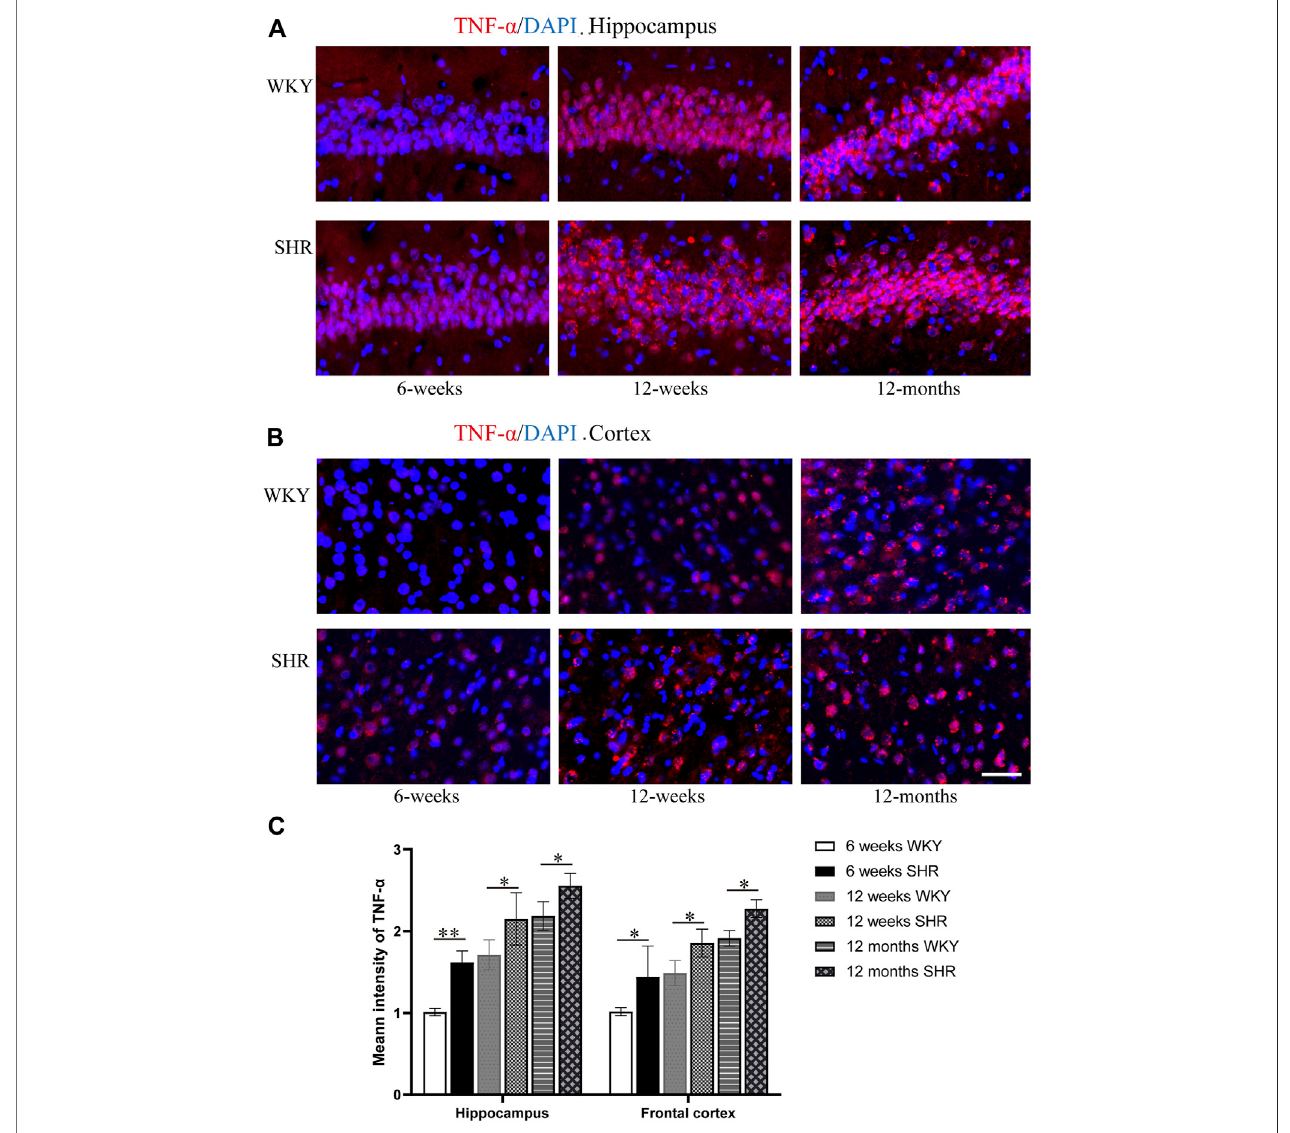
FIGURE7| TNF- α immuno fl uorescenceshowedthattheexpressionofTNF- α proteininthehippocampusandfrontalcortexofSHRwasincreasedcomparedwith that of WKY group, bar = 100 μ m. (A) The expression of TNF- α in the hippocampus CA1 region of WKY and SHR. (B) the expression of TNF- α in the frontal cortex of WKY and SHR. (C) The mean intensity of TNF- α was upregulated in the SHR at each age-matched group in the hippocampus and frontal cortex. *p < 0.05 versus age- matched WKY control. **p < 0.01, versus age-matched WKY control. The values represent mean ± SD.